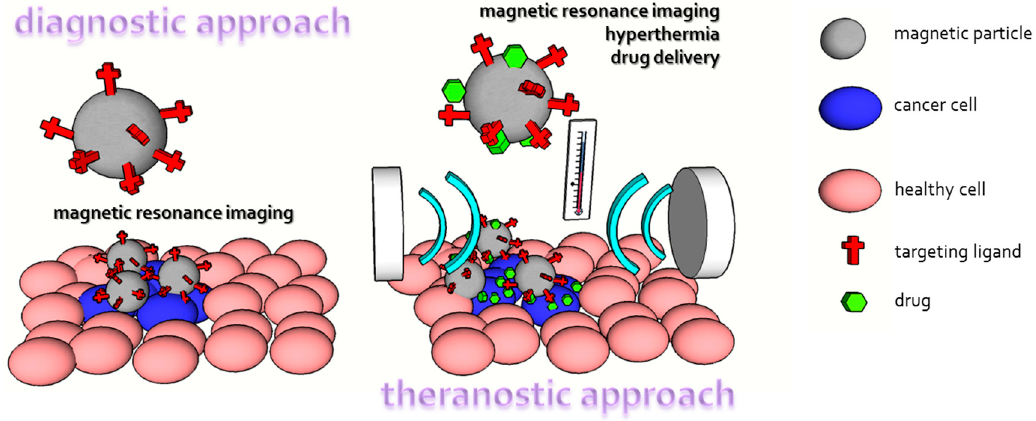
Figure 7. Comparison of magnetic particles utilization as a diagnostic and theranostic tool.